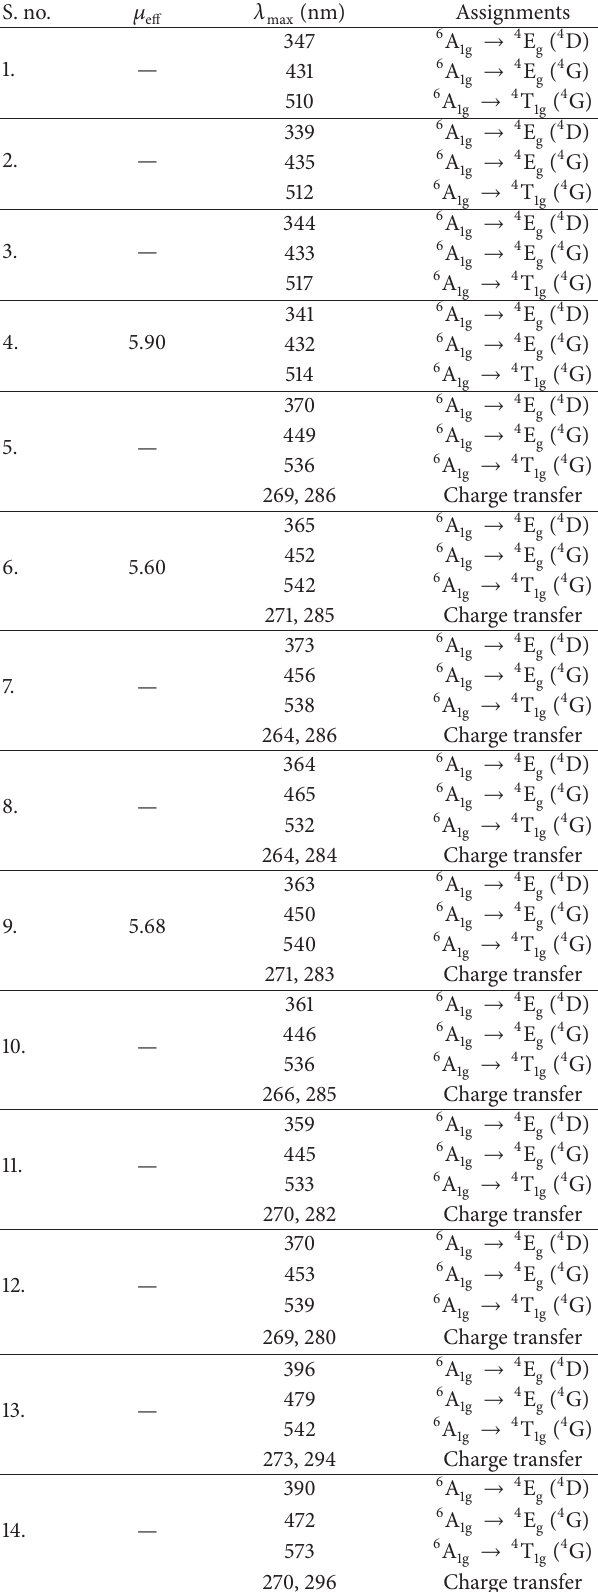
Table 4: Magnetic moment and electronic spectral data for the Mn(II) ditolyldithiophosphates. S. no. Assignments